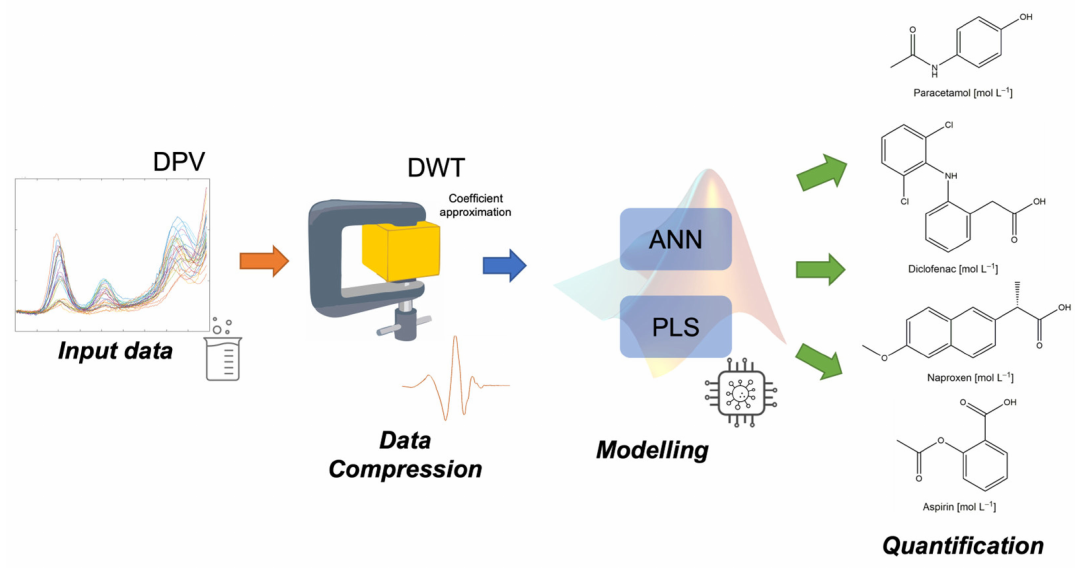
Figure 3. Scheme for modeling DPV data for the multi-quantification of the four NSAIDs